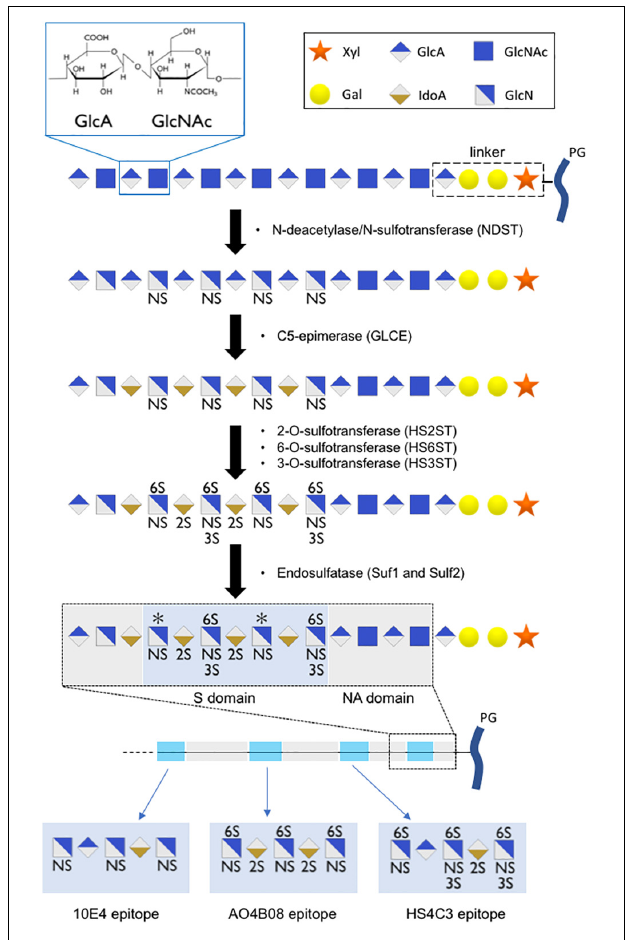
FIGURE 2 | Scheme of HS chain biosynthesis. After sequential addition of glucuronic acid (GlcA) residue and an N-acetylglucosamine (GlcNAc) residue onto a linker composed of one xylose residue (Xyl), two galactose residues (Gal), and one glucuronic acid residue, the polysaccharide undergoes a series of modifications (N-sulfation, epimerization, 2O-, 6O-, 3O-sulfation) in the Golgi apparatus, leading to the formation of highly sulfated domains with precise sulfation patterns. An additional level of HS modification occurs in the extracellular space, where secreted endosulfatases can catalyze the specific 6O-desulfation of HS chains, leading to the formation of long polysaccharide chains with high sulfation heterogeneity. We proposed short oligosaccharide sequences recognized by 10E4, AO4B08, and HS4C3